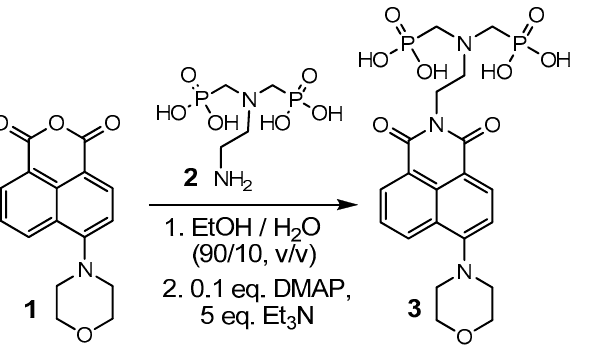
Scheme 1. General scheme of ADMP-F synthesis. Compound 1, (6-morpholinobenzo[de]isochromene- 1,3-dione); Compound 2, [[(2-aminoethyl)imino]bis(methylene)]bis(phosphonic acid); Compound 3, (2- (6-morpholino-1,3-dioxo-1H-benzo[de]isoquinolin-2(3H)-yl)ethylazanediyl)bis(methylenephosphonic